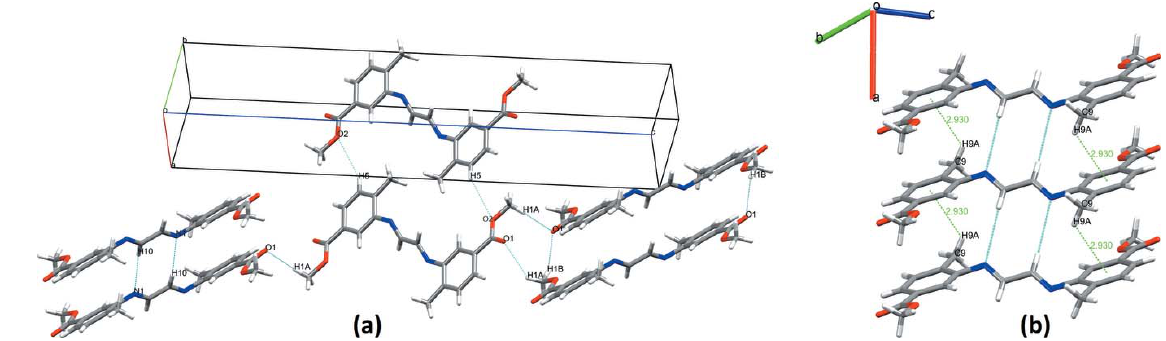
Figure 2 A view of the crystal packing of the title compound.